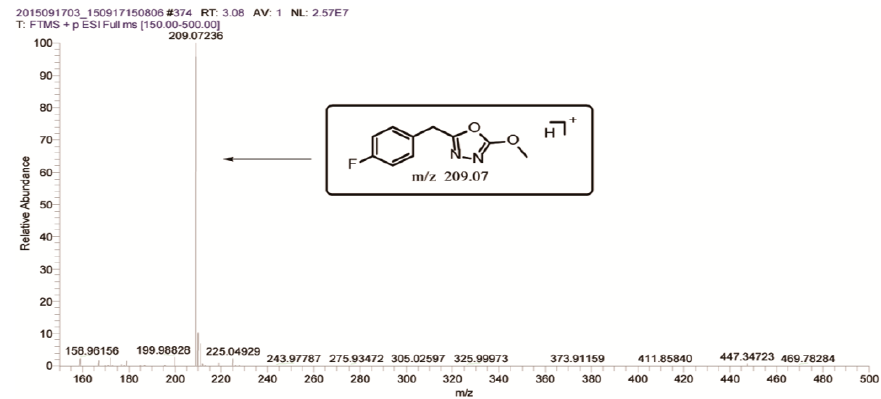
Figure 5. Mass spectrum of MS of P 1 at m / z 209.0723.